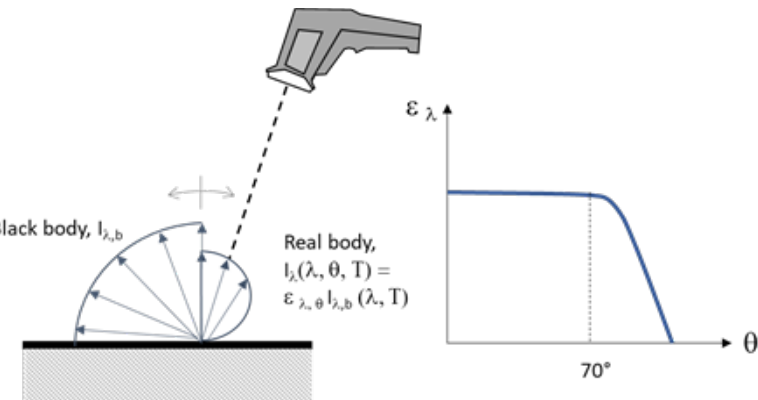
Figure 9. Influence of angle of incidence .